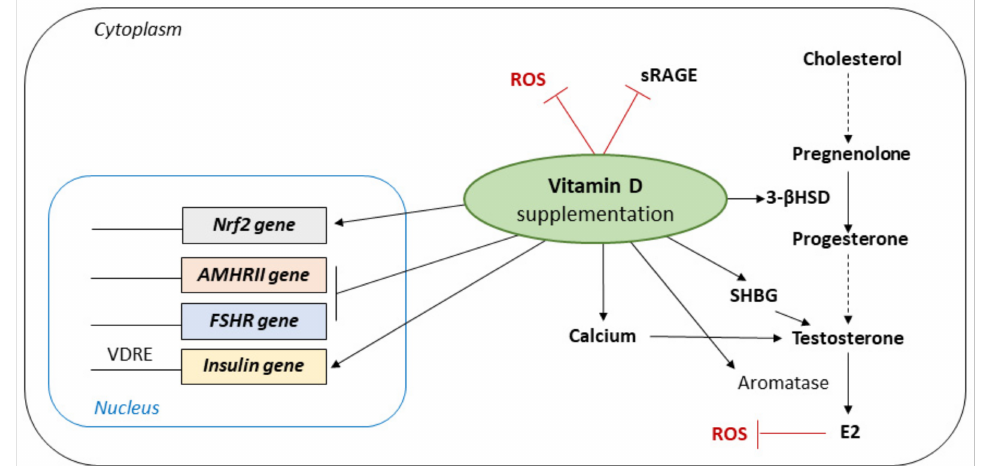
Figure 2. Impact of vitamin D supplementation on ovarian cells physiology. (Nrf2: Nuclear factor ery- throid 2-related factor 2; AMHRII: Anti-Müllerian Hormone Receptor type 2; FSHR: Follicle Stimulat- ing Hormone Receptor; VDRE: Vitamin D Response Element; ROS: Reactive Oxygen Species; sRAGE: Soluble Form of the Receptor for Advanced Glycation Endproduct; 3- β HSD: 3 β -Hydroxysteroid dehydrogenase; SHBG: Sex Hormone Binding Globulin; E2: